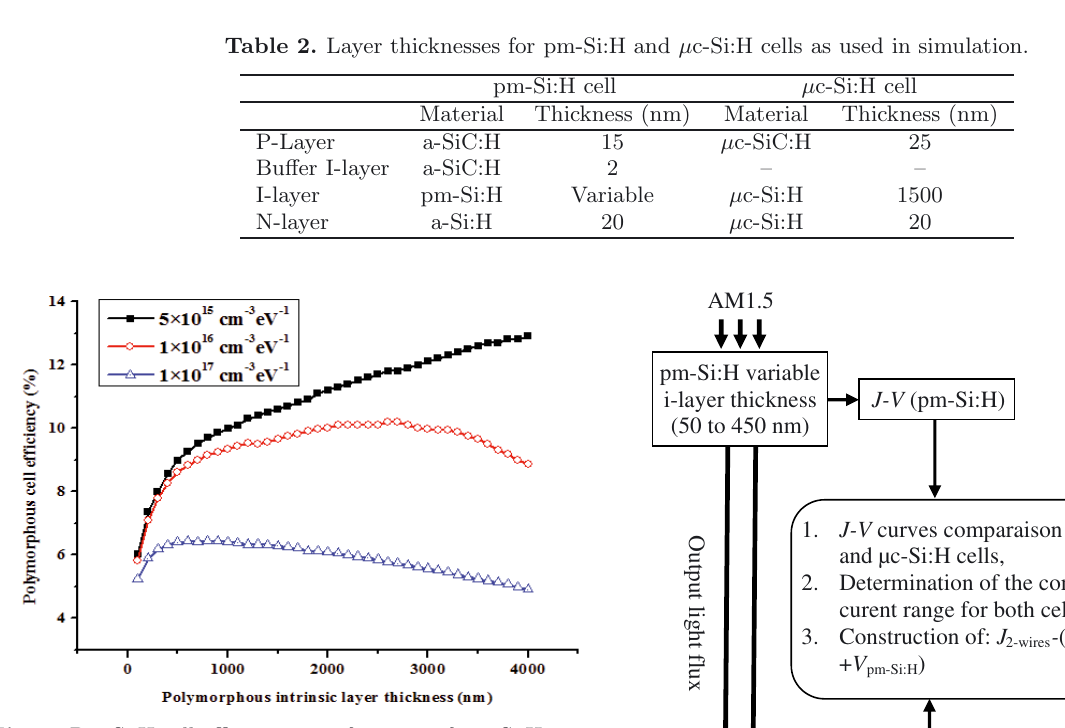
Fig. 2. Pm-Si:H cell efficiency as a function of pm-Si:H intrin- sic layer thickness for three values of the Gaussian distribu- tion peak value D max (expressed in cm − 3 eV − 1 ): 5 × 10 15 ( ), 1 × 10 16 ( ◦ ) and 1 × 10 17 ( (cid:4) ).